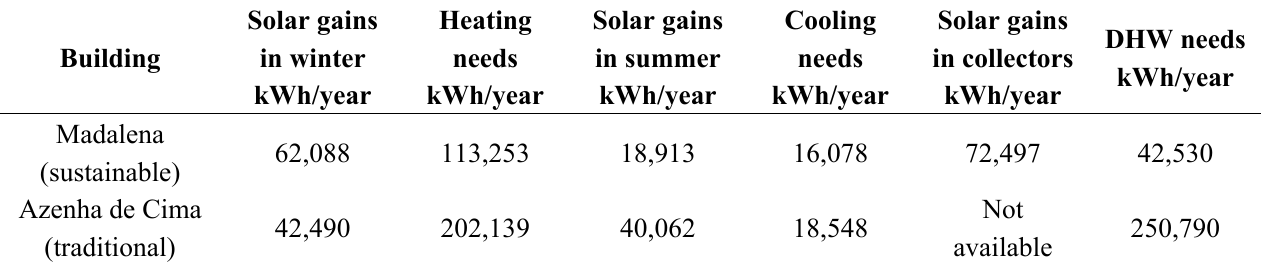
Table 9. Global annual energy needs and solar gains—Madalena vs . Azenha de Cima.